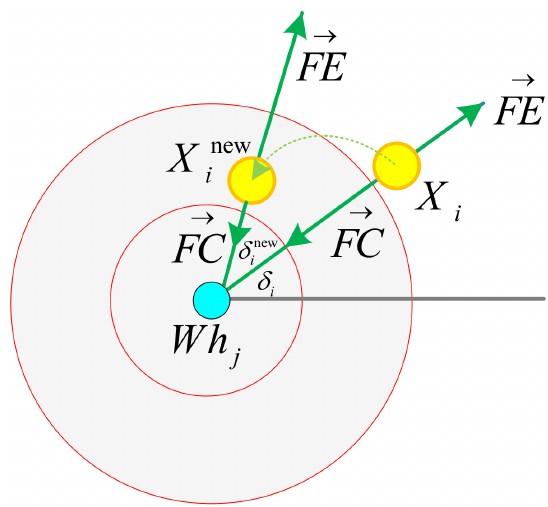
Figure 2. Acting forces in whirlpools.